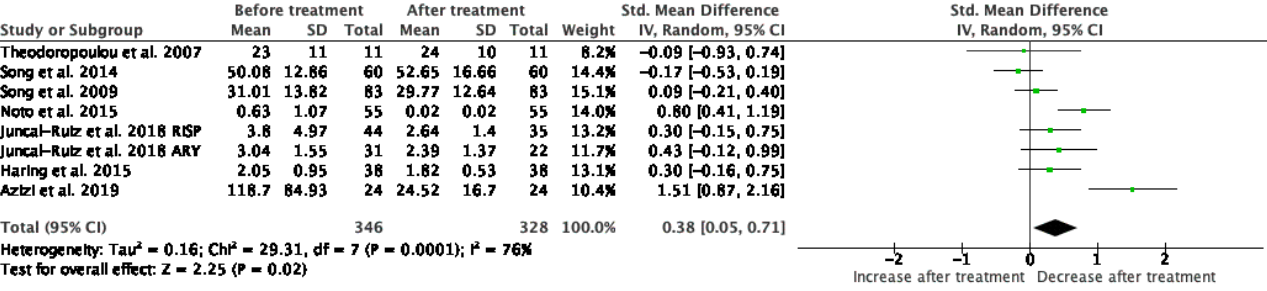
Figure 6. Meta-analysis of TNF- α .